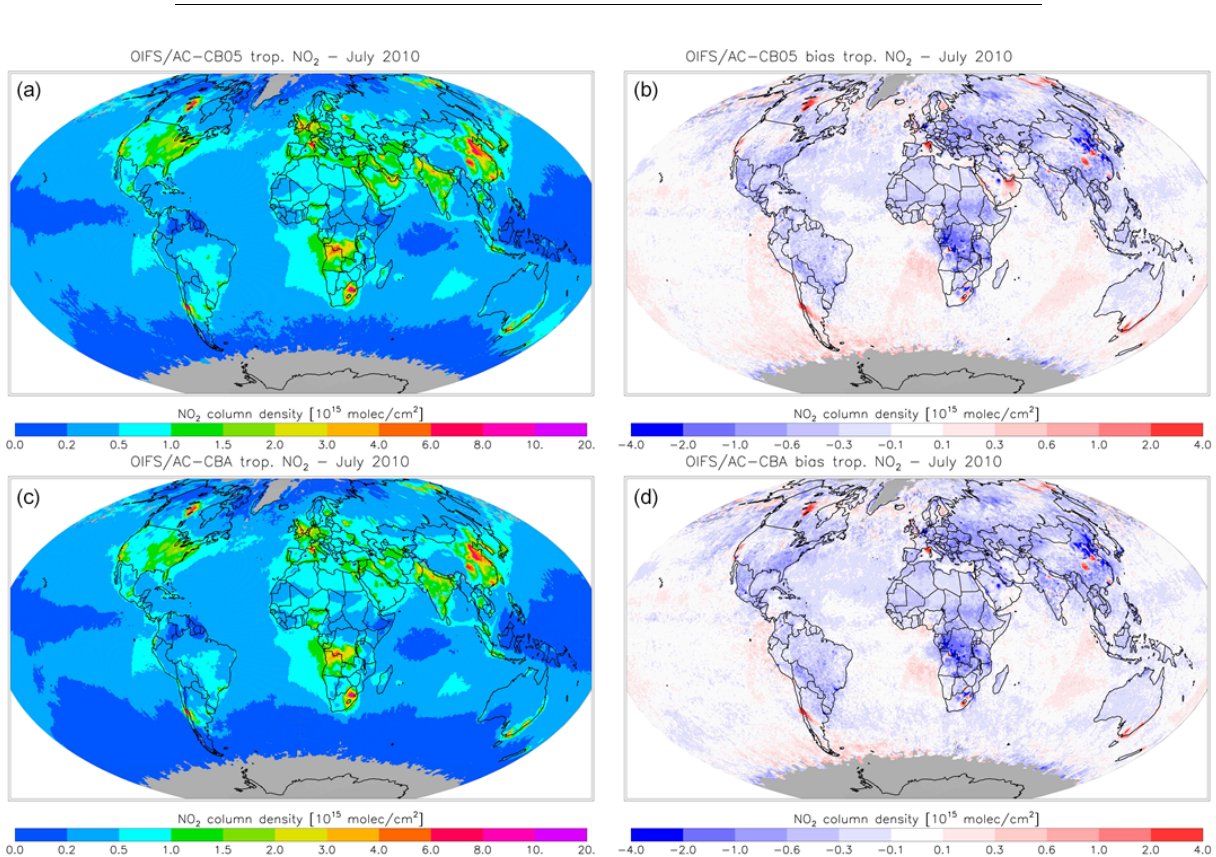
Figure 7. Evaluation of OpenIFS/AC-CB05 (a, b) and OpenIFS/AC-CBA (c, d) tropospheric NO 2 columns against OMI observations, averaged for July 2010. (a, c) Model tropospheric NO 2 columns. (b, d) Model bias with respect to the